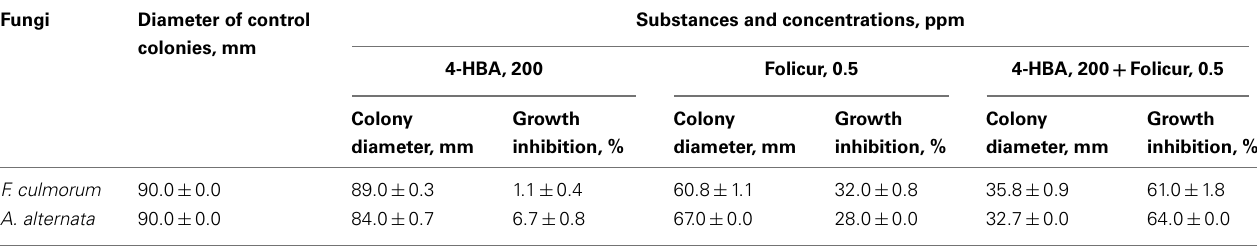
Table 2 | Fungicidal effect of 4-HBA, Folicur and their mixture toward F. culmorum and A. alternata at day 10 of in vitro testing. Fungi